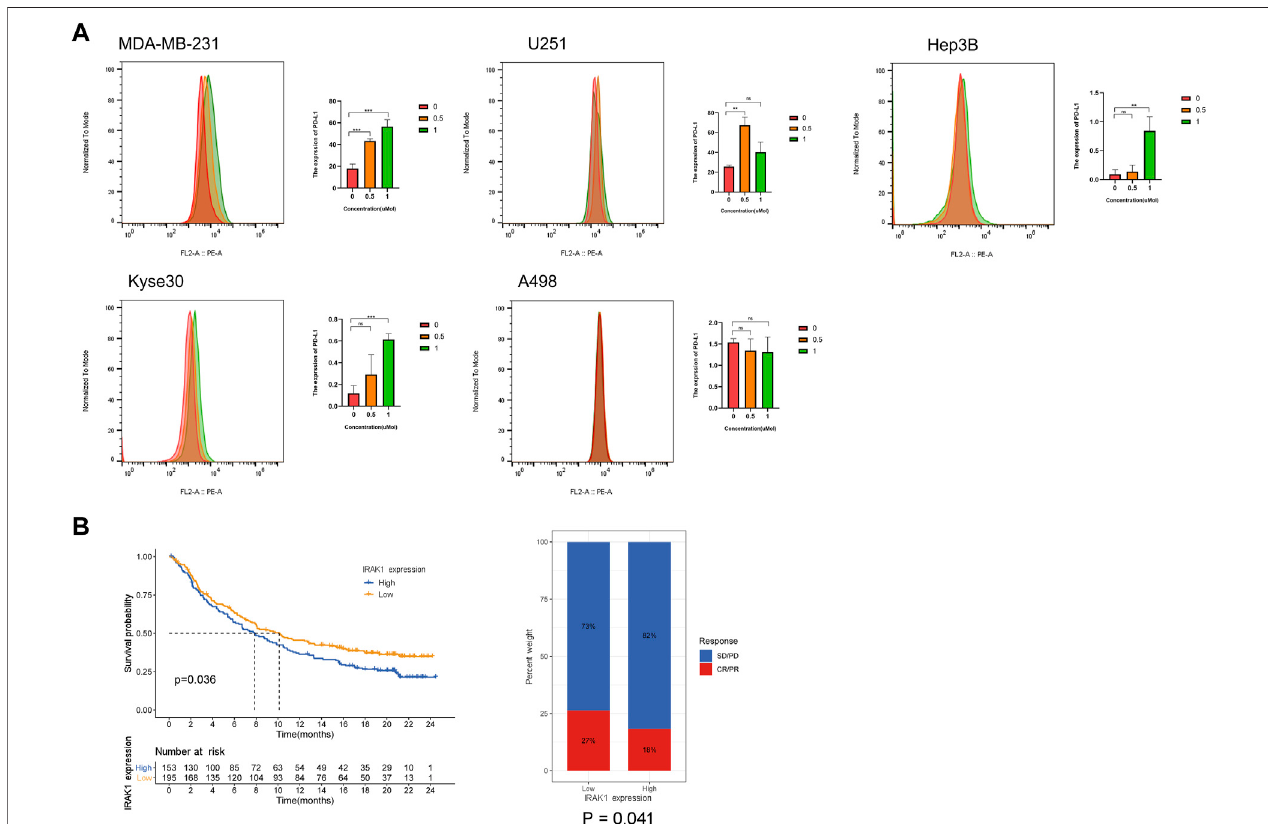
FIGURE 8 | IRAK1 expression predicts the bene fi ts in the immunotherapeutic treatments. (A) MDA-MB-231, U251, Hep3B, Kyse30 and A498 cells treated with DMSO control and IRAK1 inhibitors pacritinib (0.5µM, 1 µM) for 48 h were subjected to FACs analysis for cell surface PD-L1 expression. Quanti fi cation of PD-L1 is shown. Every experiment was run in three independent experiments. * < 0.05, ** < 0.01, *** p < 0.001. (B) Patients receiving anti-PD-L1 immunotherapy in the IMvigor210 cohort were assigned high or low IRAK1. Notably, in the IMvigor210 cohort, patients with low IRAK1 had signi fi cantly better outcomes than those with high IRAK1 ( p =0.036).IntheIMvigor210cohort,theobjectiveresponseratetoanti-PD-L1therapywashigherinthelowIRAK1groupthaninthehighIRAK1group(27vs.18%, p = 0.041).TheIMvigor210datasetwasdownloadedfromafreelyavailable,fullydocumentedsoftwareanddatapackage,undertheCreativeCommons3.0licensethatcan be downloaded from http://research-pub.gene.com/IMvigor210CoreBiologies. A total of 298 urothelial cancer cases with complete clinical information, were analyzed to determine the immunotherapy